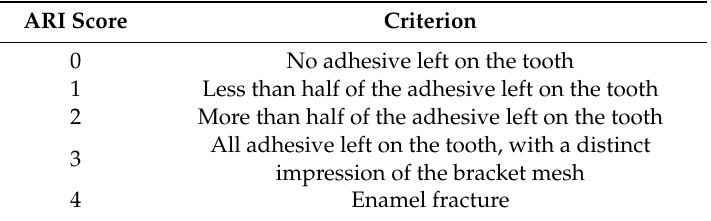
Table 2. Adhesive remnant index (ARI) score and criterion. ARI Score